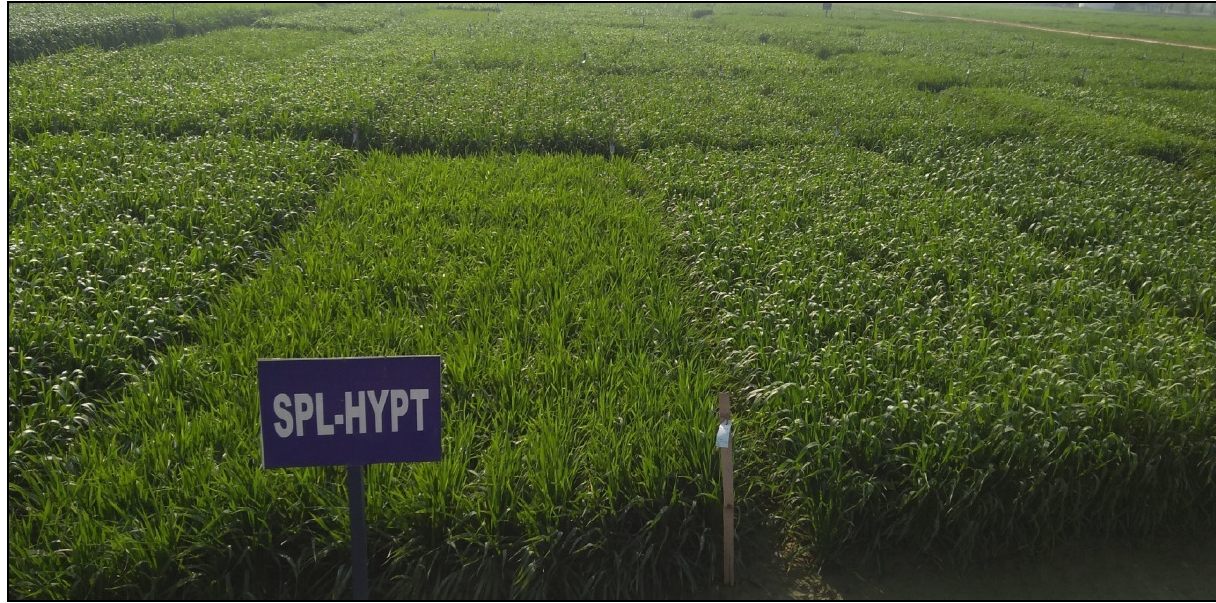
Figure 2. Field view of the SPL-HYPT trial at Karnal, India.